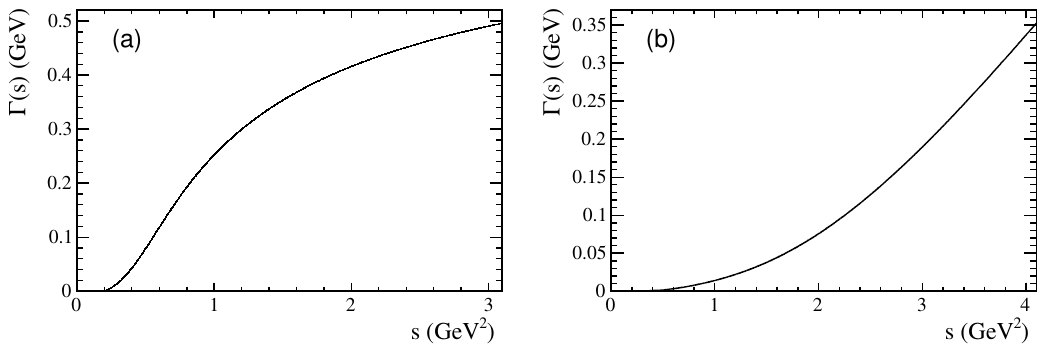
Figure 15 . Final iteration of the energy-dependent width for the (cid:25) (1300) (a) and a 1 (1640) (b) resonances.